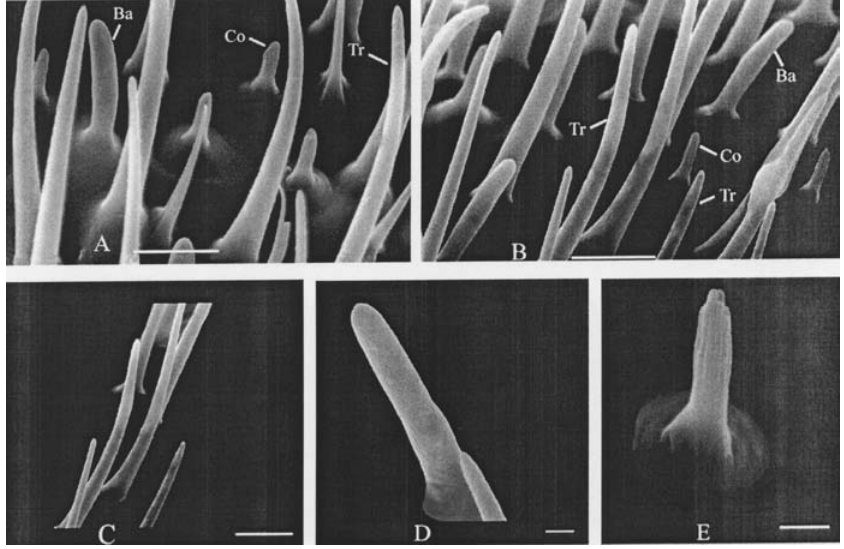
Fig.2 SEM micrographs of antennal sensilla of the decapitating phorid fly P. litoralis female (A and B) antennal sensilla on flagellum: (Ba) sensilla basiconica, (Co) sensilla coeloconica, and (Tr) sensilla trichodea; (C) sensilla trichodea; (D) sensilla basiconic; (E) sensilla coeloconica. Scale bars: (A , B and D) 5μm; (C and E)